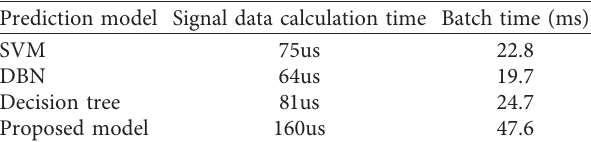
Figure 21: Comparison of the accuracy of different prediction models. Table 5: Calculation time of different prediction